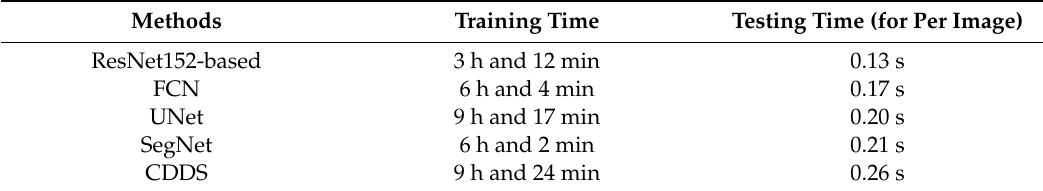
Table 5. Comparison of training and testing time for ResNet152-based, FCN, Unet, SegNet and